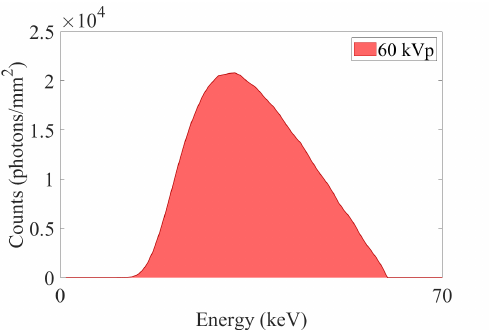
Figure 5. X-ray spectrum of tungsten target employed from the spektr toolset in MATLAB ® for simulation. The spectrum is filtered by 0.5 mm aluminum